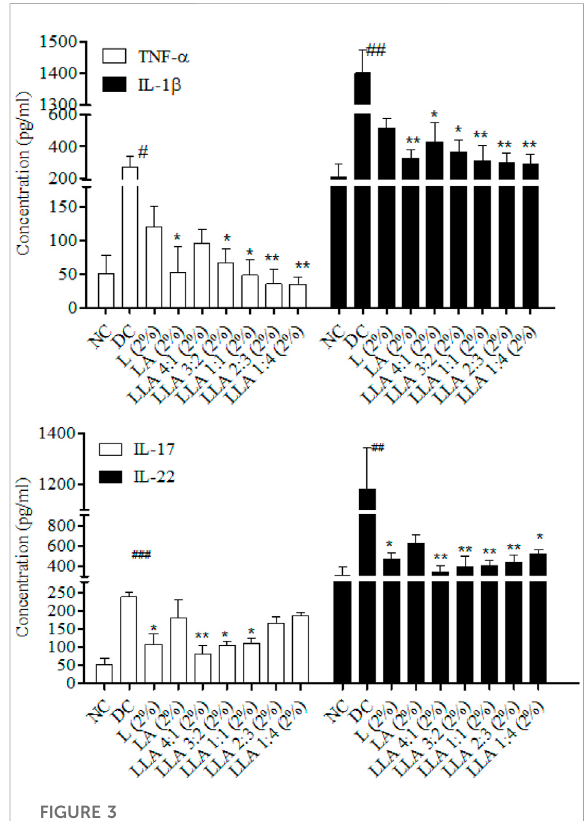
FIGURE 3 LevelsofTh-17andTh-1cell-speci fi ccytokinesinskintissues of linalool and linalyl acetate combination-treated mice. NC; normal control, DC; disease control, LLA (2%); linalool + linalyl acetate in 4:1, 3:2, 1:1, 2:3, and 1:4 ratios at 2% concentration. The data represent mean ± SEM, n = 6. # p < 0.05, ## p < 0.01 and ### p < 0.001 (NC vs. DC), * p < 0.05 and ** p < 0.01 (DC vs.